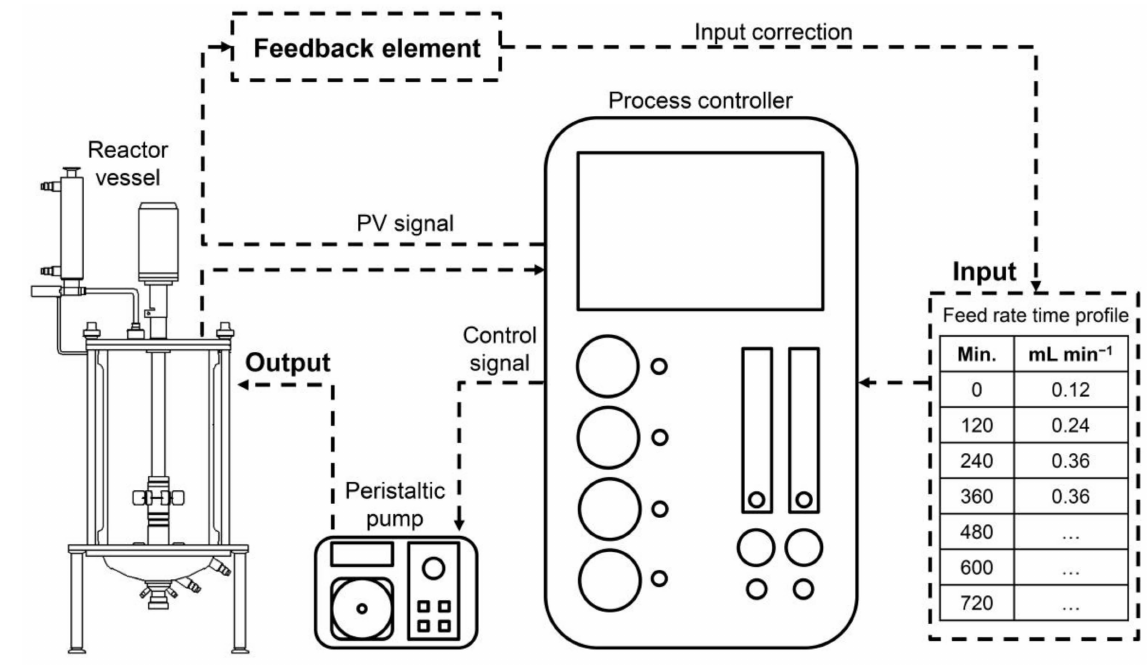
Figure 4. An example of closed-loop (feedback) feed rate control in a